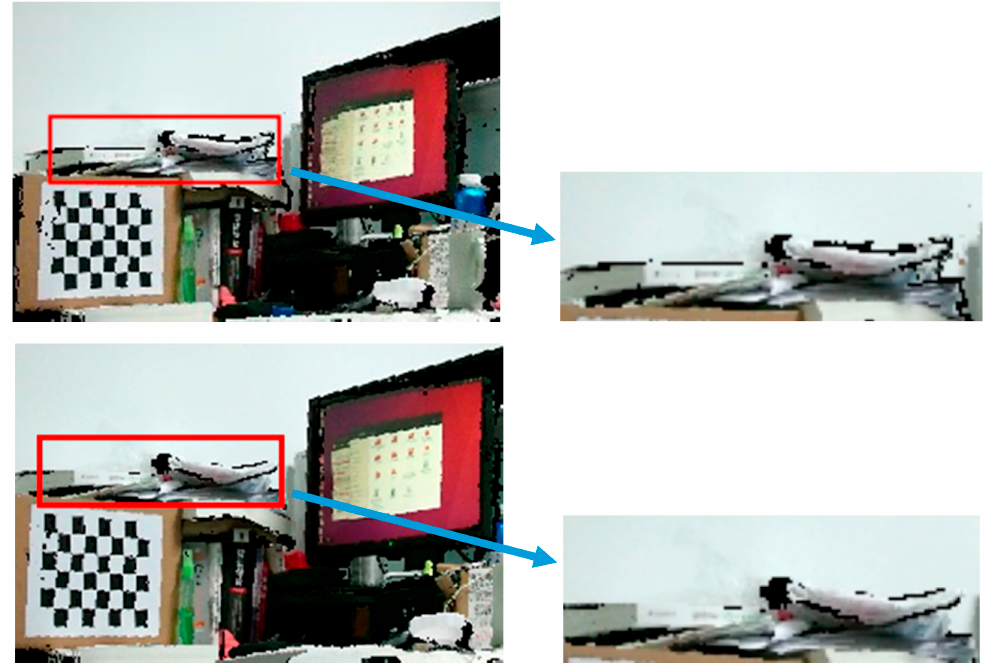
Figure 9. Point cloud of an indoor scene before ( top ) and after ( bottom ) correction using the post-rectification approach.